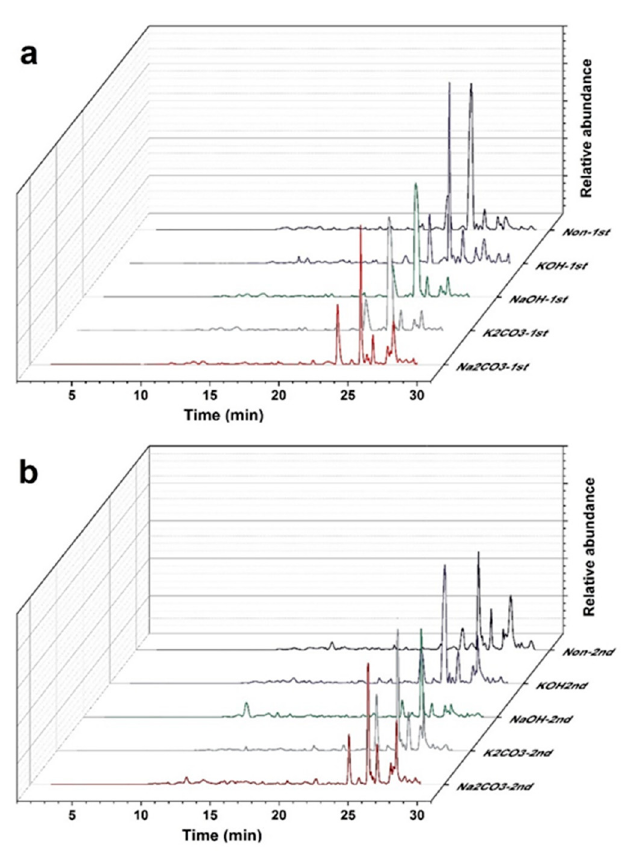
Figure 5. GC-MS analysis results of ( a ) first cycle- and ( b ) second cycle-driven bio-crudes.